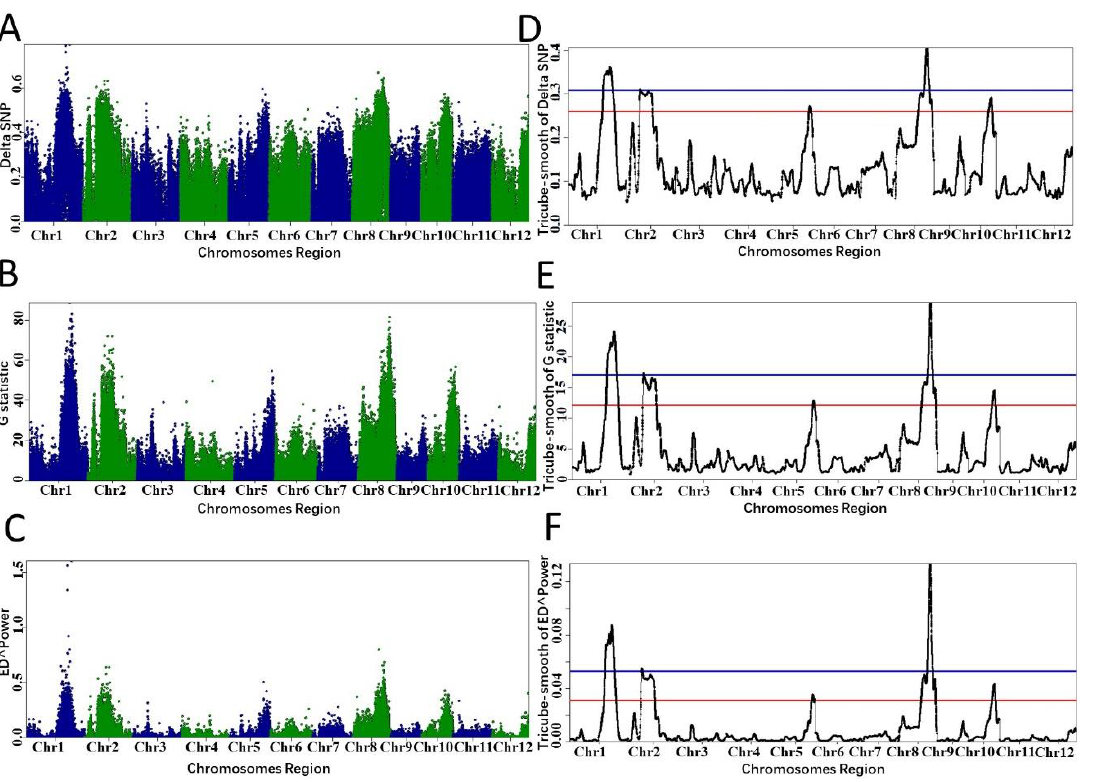
Figure 4. QTLs identified by different algorithms in PNGseqR for rice seedling cold tolerance. Note: The “plot_BSA()” function was used to draw the plot with a 5 Mb sliding window. ( A – C ) The scatter plots were exported from the BSA results, and the algorithms were ΔSNP, G -test, and ED. ( D – F ) The tricube-smoothed values of the corresponding statistics. The red line is the threshold set by the >85% quantile, and the blue line is the threshold set by p -values < 0.01.